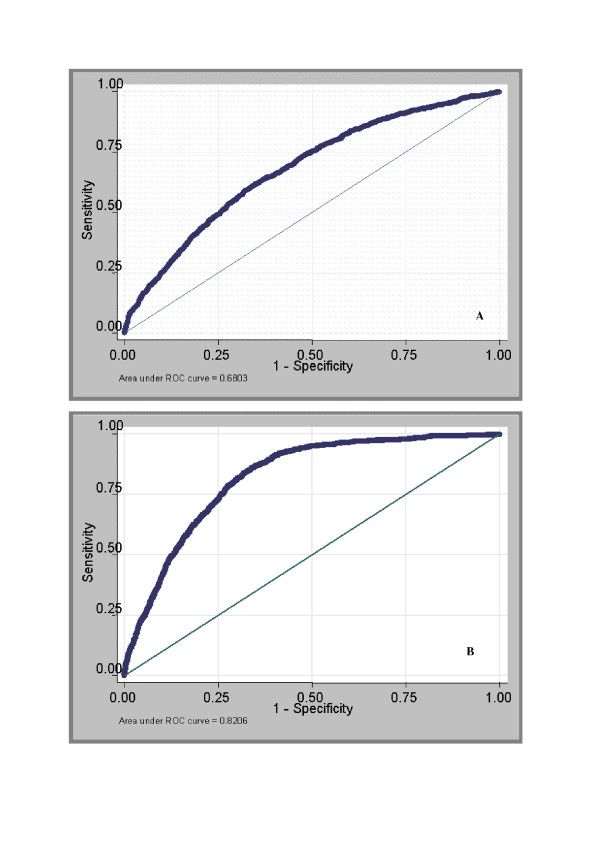
Receiver-operator characteristic curve of amputation. Legend: ROC curves of amputation without clinical indication in the model (Figure 1A) and with clinical indication in the model (Figure 1B)